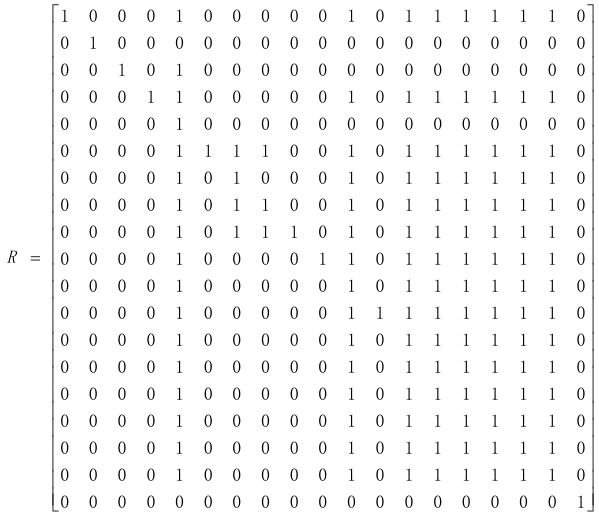
Figure 6. Reachability matrix.